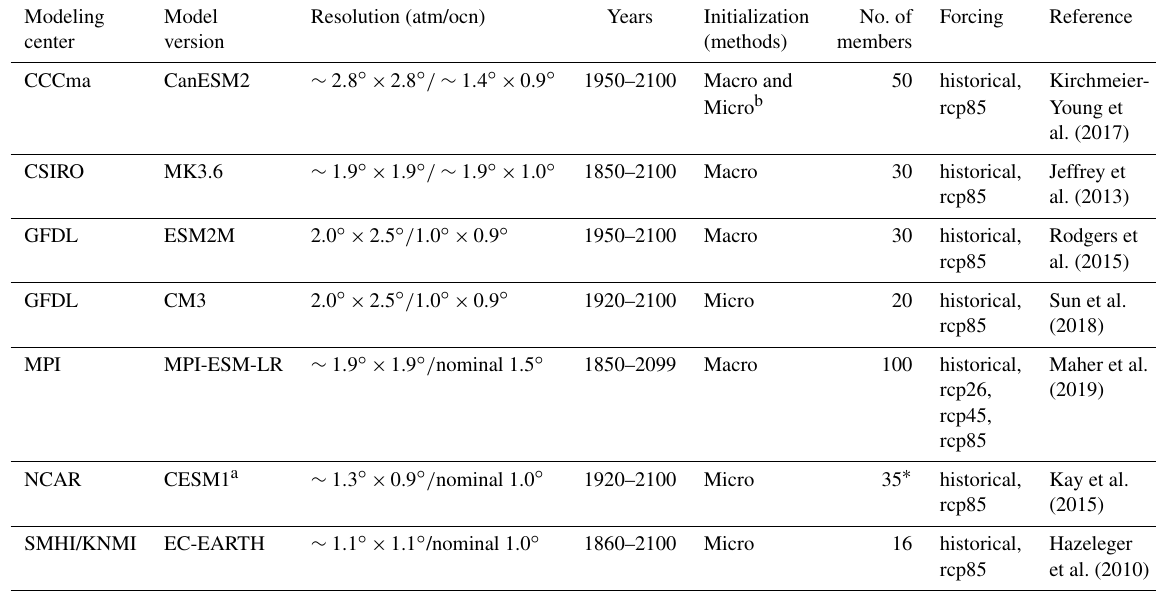
Table 1. Single-model initial-condition large ensembles (SMILEs) used in this study. Table reproduced from Deser et al. (2020). See also http://www.cesm.ucar.edu/projects/community-projects/MMLEA/ (last access: 27 May